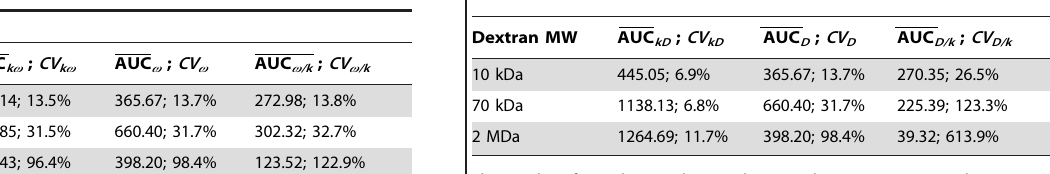
Table 2. The average AUC and coefficient of variation (CV) values corresponding to different permeability of carriers shown in Figure 5.